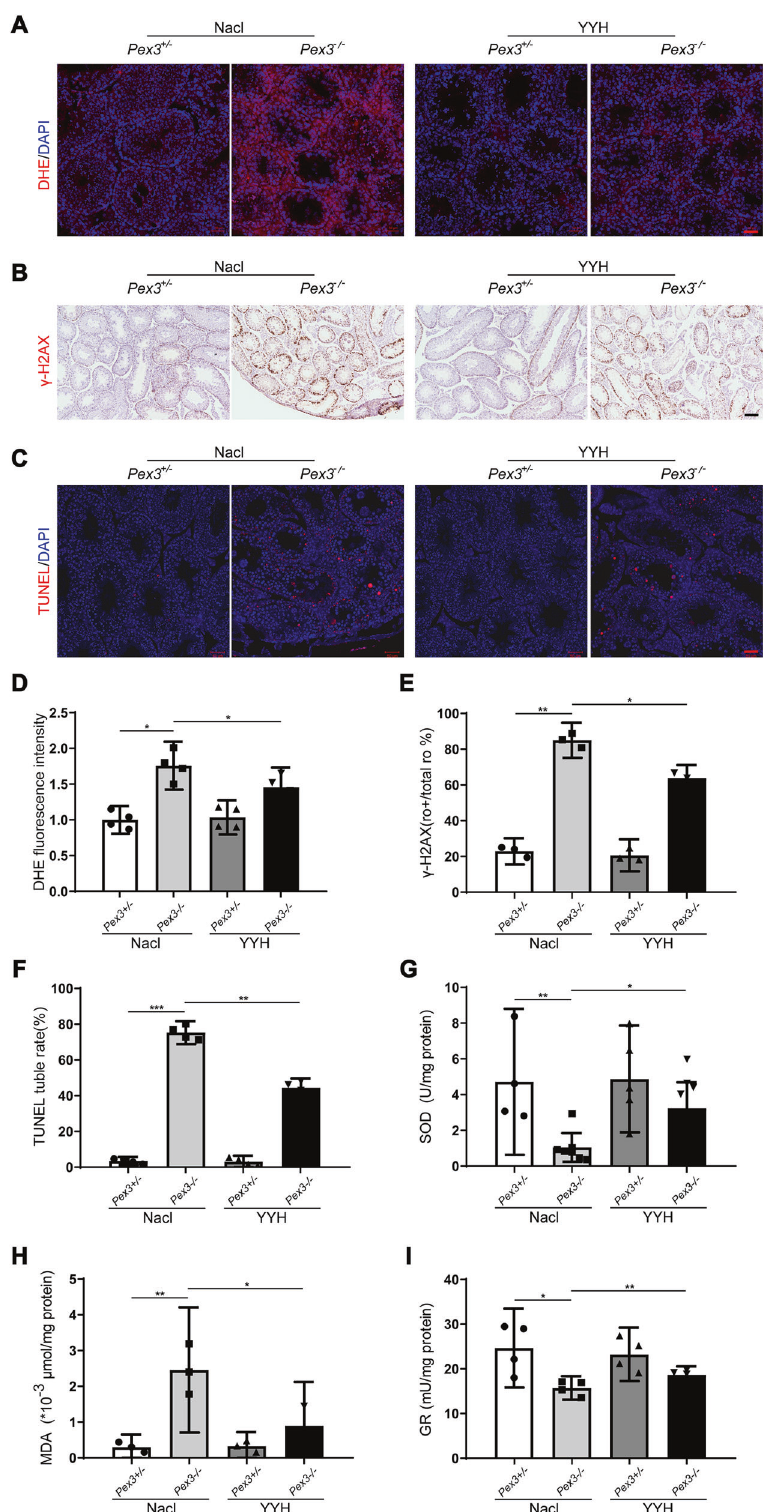
Fig. 4 Effects of YYH supplementation on OS levels in testicular tissues of Pex3 -KO mice. ( n = 3 – 8). A DHE fl uorescence (red) in testicular tissue from each group. Scale bars: 50 μ m. B Images of γ -H2A.X immunohistochemical staining in testicular tissue from each group. Scale bars: 100 μ m. C Image of TUNEL staining (red fl uorescence) showing testicular apoptosis in each group. Scale bars: 50 μ m. D DHE fl uorescence intensity. E Rate of γ -H2AX-positive luminal cells. F Rate of TUNEL-positive luminal cells. G SOD level. H MDA level. I GR